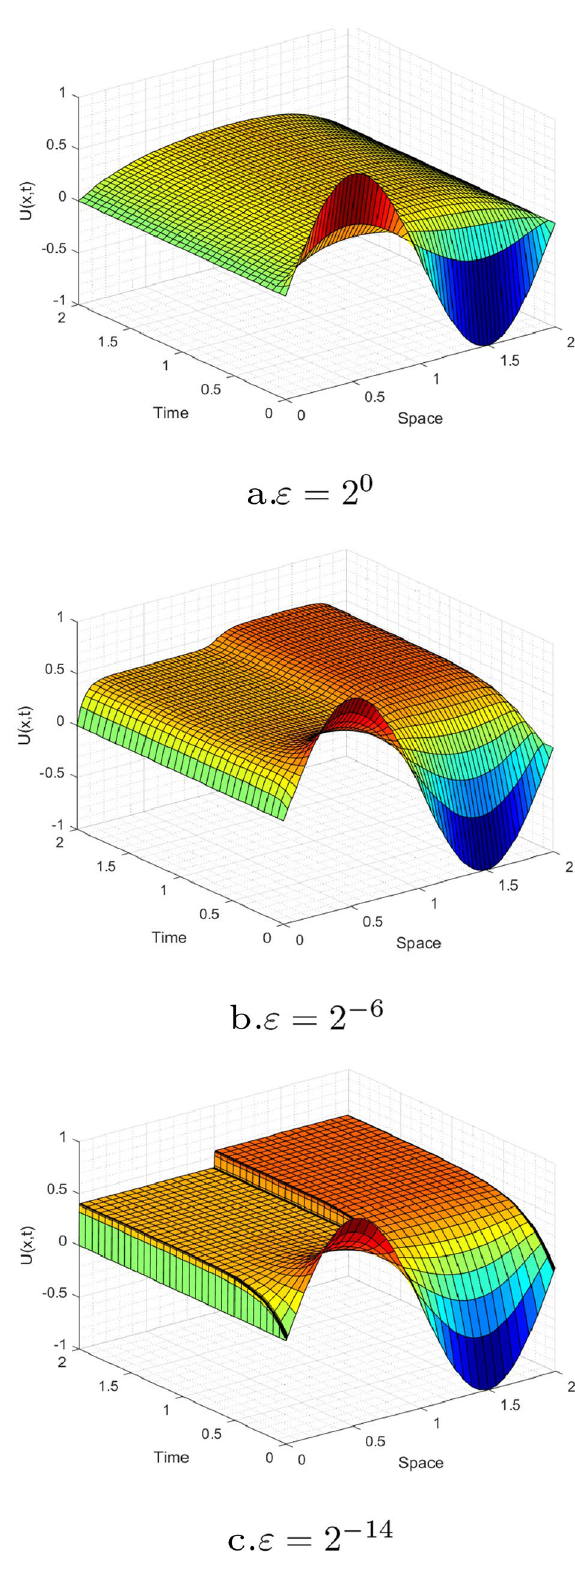
Fig. 3 Simulations for the numerical solution of Example 1, taking 𝜃 =0.5, 𝛽 =1, N =72 and M =72 for different perturbation parameters (surface plots)